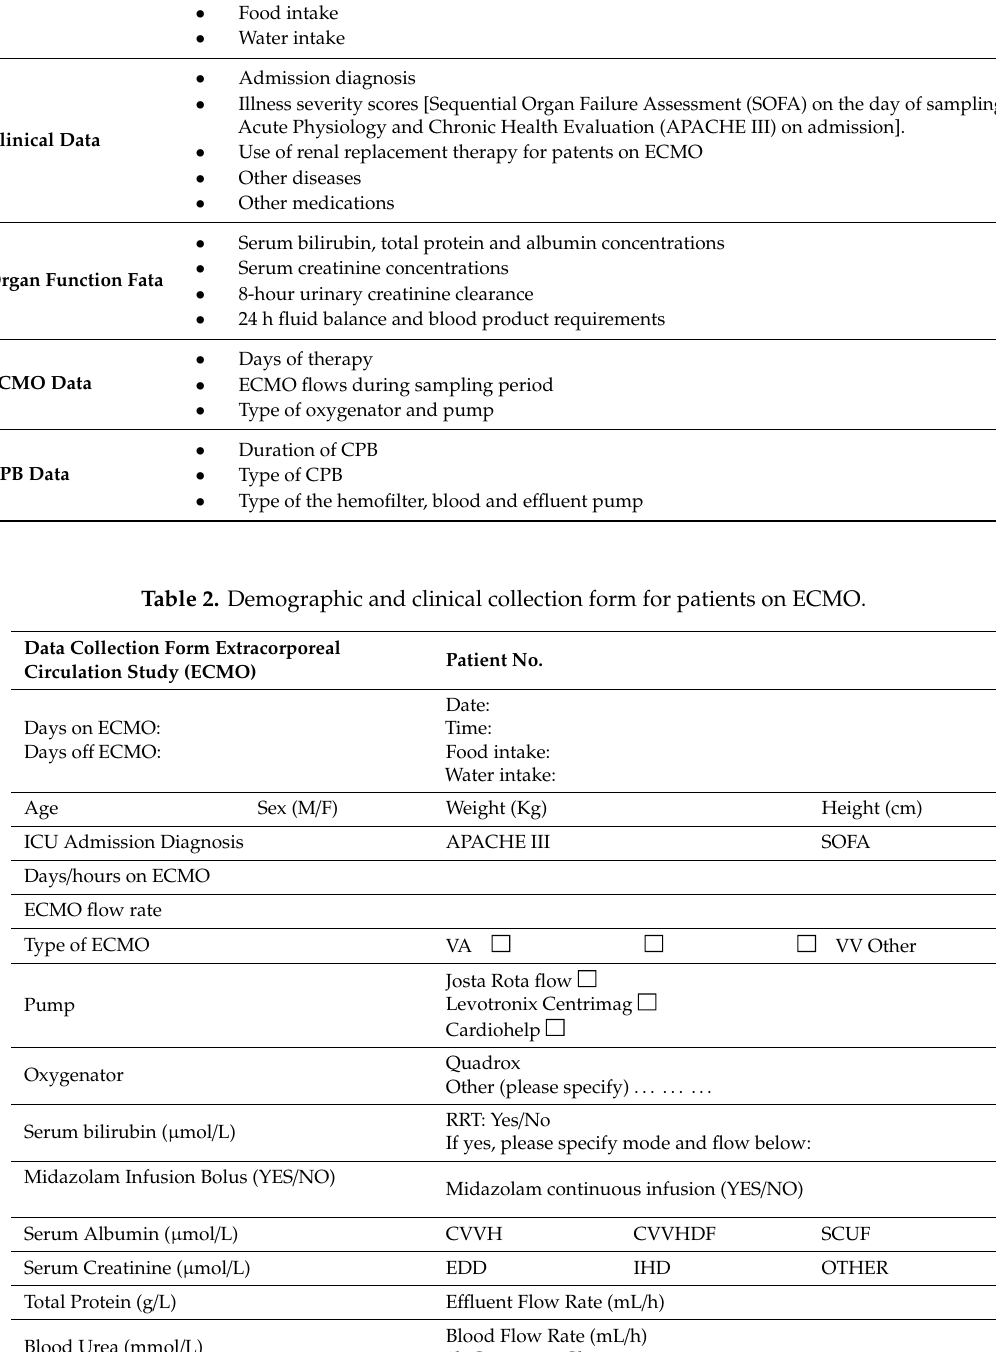
Table 3. Demographic and clinical data collection form for patients on CPB. Data Collection form Extracorporeal Circulation Study (CPB) Patient No. Date: Time: Food intake: Water intake: Age Sex (M/F) Weight (Kg) Height (cm) ICU Admission Diagnosis Hours on CPB Type of CPB Hypothermia Blood pump flow rate Type of membrane Serum bilirubin (µmol/L) 8 h Creatinine Clearance Serum Creatinine (µmol/L) Serum Albumin (g/L) Total Proteins (g/L) Blood Urea (mmol/L) Sample